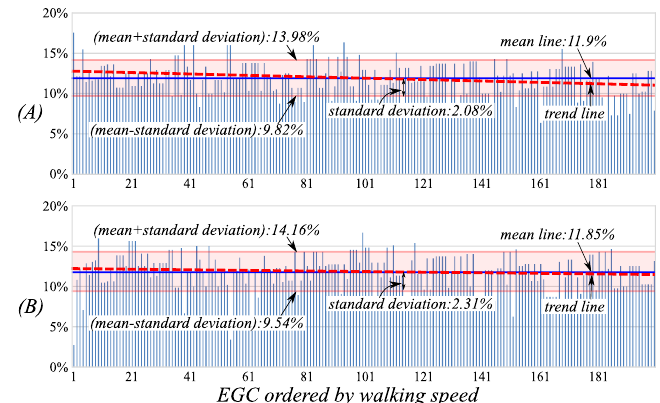
Figure 10. The percentage distributions of the term-LSw ( A ) and term-RSw ( B ) in the cycle during the EGC. The walking speeds of the EGC increase gradually along the horizontal